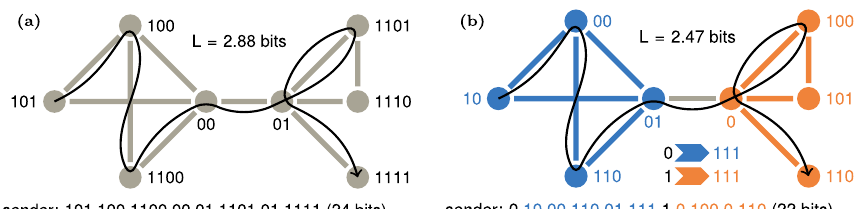
Fig. 1 A communication game on a network where colours indicate module assignments and node labels show codewords. The black trace shows a possible node sequence during a random walk; the corresponding sequence of codewords to describe the walk is shown in the bottom. The average per-step codelength is shown as L . a The one-level partition where all nodes are in the same module and there is only one codebook. b Nodes are split into two modules with one codebook per module and an additional index-level codebook, indicated by coloured arrows. Module entry and exit codewords are shown on the left and right of the arrows, respectively. The codelength L is reduced because the partition captures those areas where the random walker tends to stay for a longer